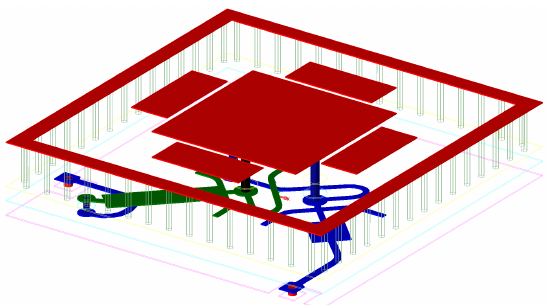
Figure 12. 3D model of full layout (ground planes and grounding vias omitted).